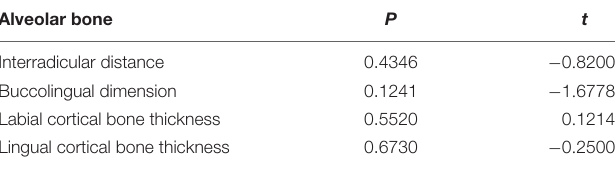
TABLE 1 | Comparison result of male and female scanning data.